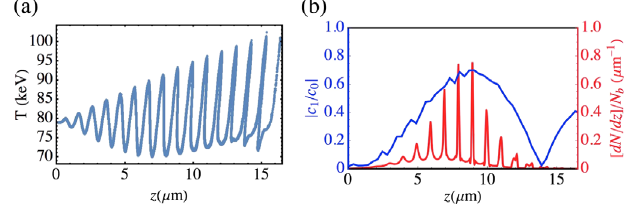
FIG. 8. Plots of the (a) longitudinal phase space distribution from GPT tracking of a long (50 fs) uniformly distributed bunch; (b) bunching factor (blue) predicted from the resonant particle model and the corresponding density profile (red) of the distribution from (a) as a function of propagation distance z . The bounds of the plots in z correspond to the entrance and exit of the tapered